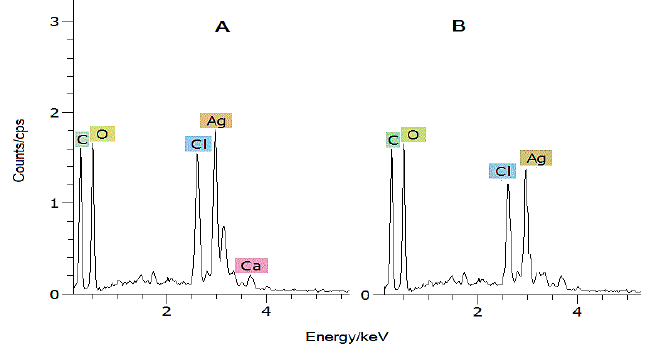
Figure 3. EDX spectra of AgCl-NPs, synthesized using Ag + and Cl − in different concentrations of Ag + (( A )—8 mM AgNO 3 ; ( B )—6 mM AgNO 3 ).